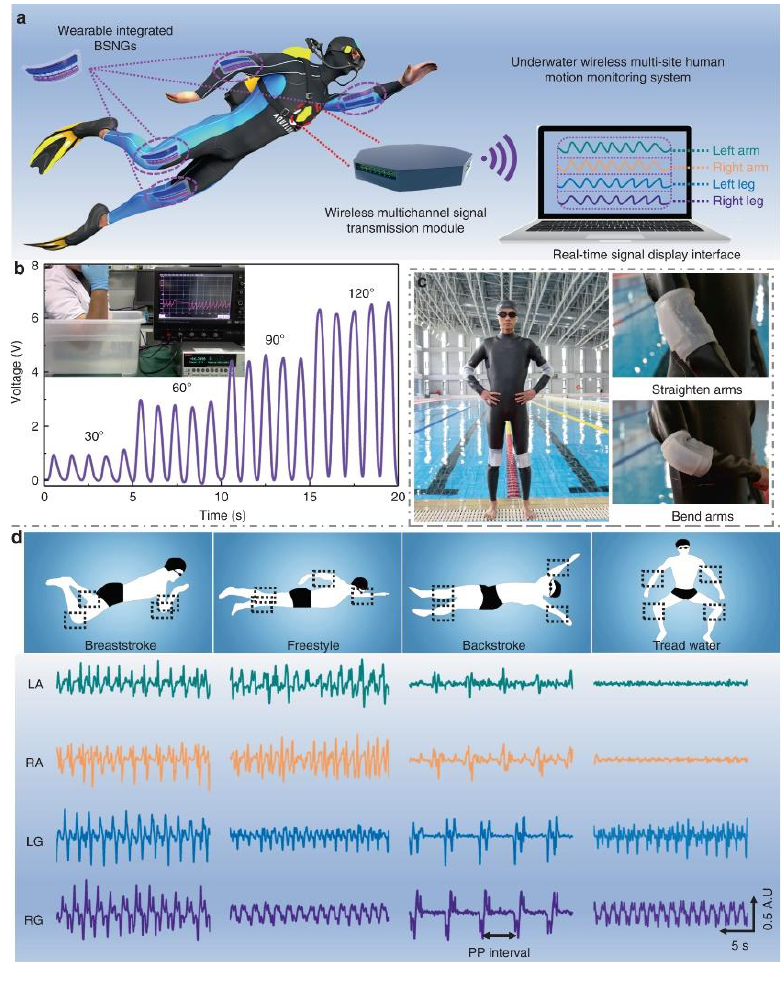
Figure 5. “Underwater wireless multi-site human motion monitoring system. ( a ) Illustration of underwater wireless multi-site human motion monitoring system based on bionic stretchable nano- generator (BSNG). ( b ) Signal outputs of BSNG fixed on the elbow at different curvature motion. ( c ) Photographs of integrated wearable BSNG worn on the arthrosis of humans. ( d ) Signal outputs recorded by underwater wireless multi-site human motion monitoring system when the volunteer swam in different strokes (LA, RA, LG, RG represent left arm, right arm, left leg, right leg, respectively; PP interval represents the time interval between two peaks) ” [ Y. Zou et al., “A bionic stretchable nanogenerator for underwater sensing and energy harvesting,” Nat. Commun. , vol. 10, no. 1, p. 2695, Dec. 2019].